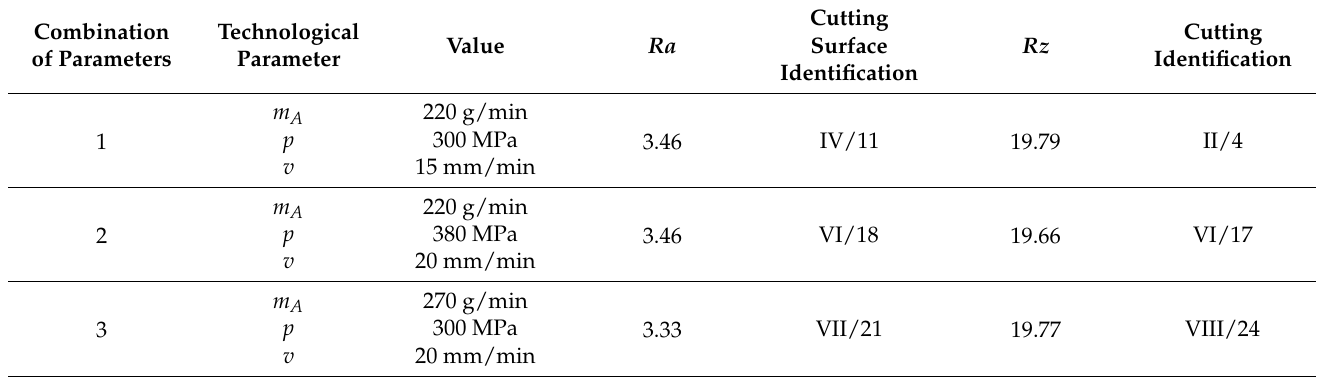
Table 3. Example of combinations of values of technological parameters for achieving approximately equal (average) roughness Ra = 3.41; Rz = 19.72.